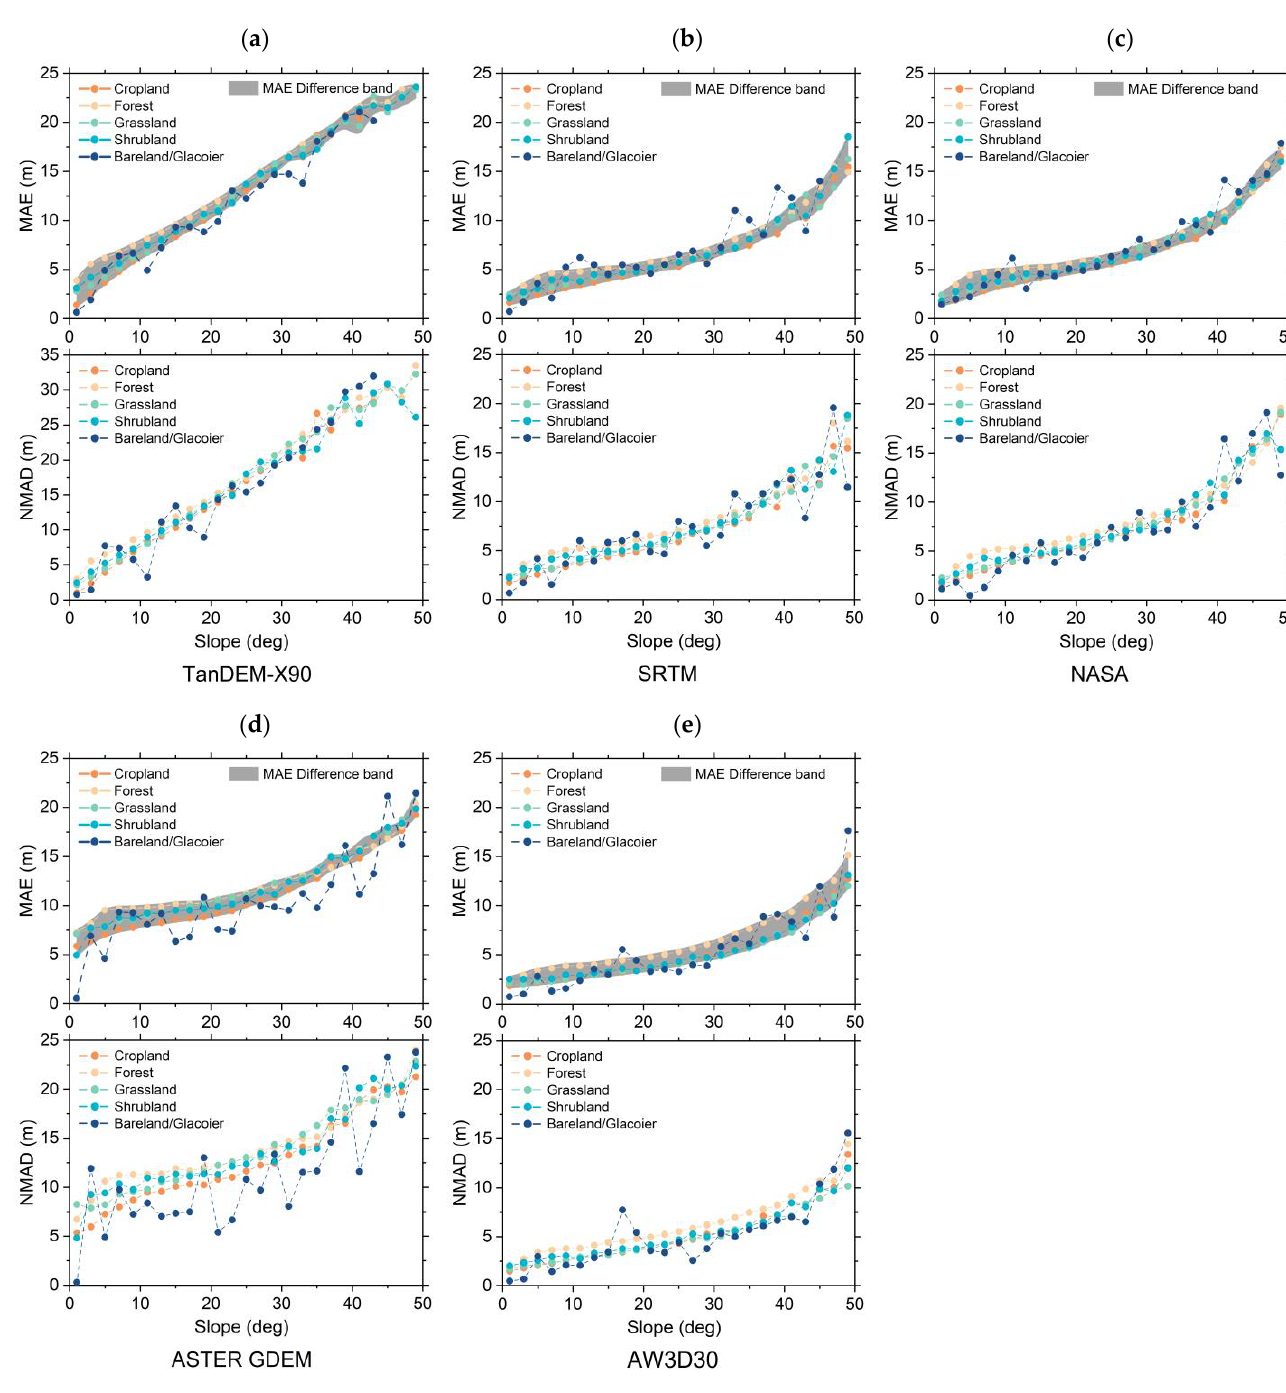
Figure 14. Relationship between quality indicators ( MAE on the top and NMAD on the bottom) and slope under different landcover types. ( a ) TanDEM-X90, ( b ) SRTM, ( c ) NASA, ( d ) ASTER GDEM, and ( e ) AW3D30. and ( e )